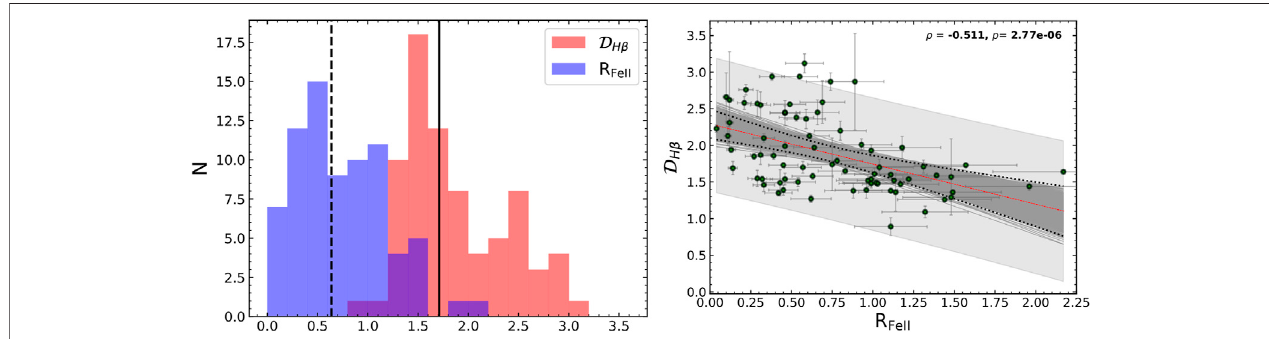
FIGURE 4 | (Left) Distribution of D H β (in red) and R FeII (in blue) for the sample from Du and Wang (2019) and as shown in Supplementary Table S4 . The median valuesforthetwoparametersareshownusingtheverticallines – solid ( D H β ) anddashed(R FeII )(right)Correlationbetween D H β andR FeII forthissample[seealso Figure2 in Du and Wang (2019)]. Spearman ’ s rank correlation coef fi cients ( ρ ) and the p − values are also reported. The ordinary least-square (OLS) fi t for each panel is shown using red solid line.Black dotted linesmark thecon fi dence intervals at 95% forthe 1,000 realizations (dark gray lines) ofthebootstrap analysis.The corresponding prediction intervals are shown in the background using light gray color.